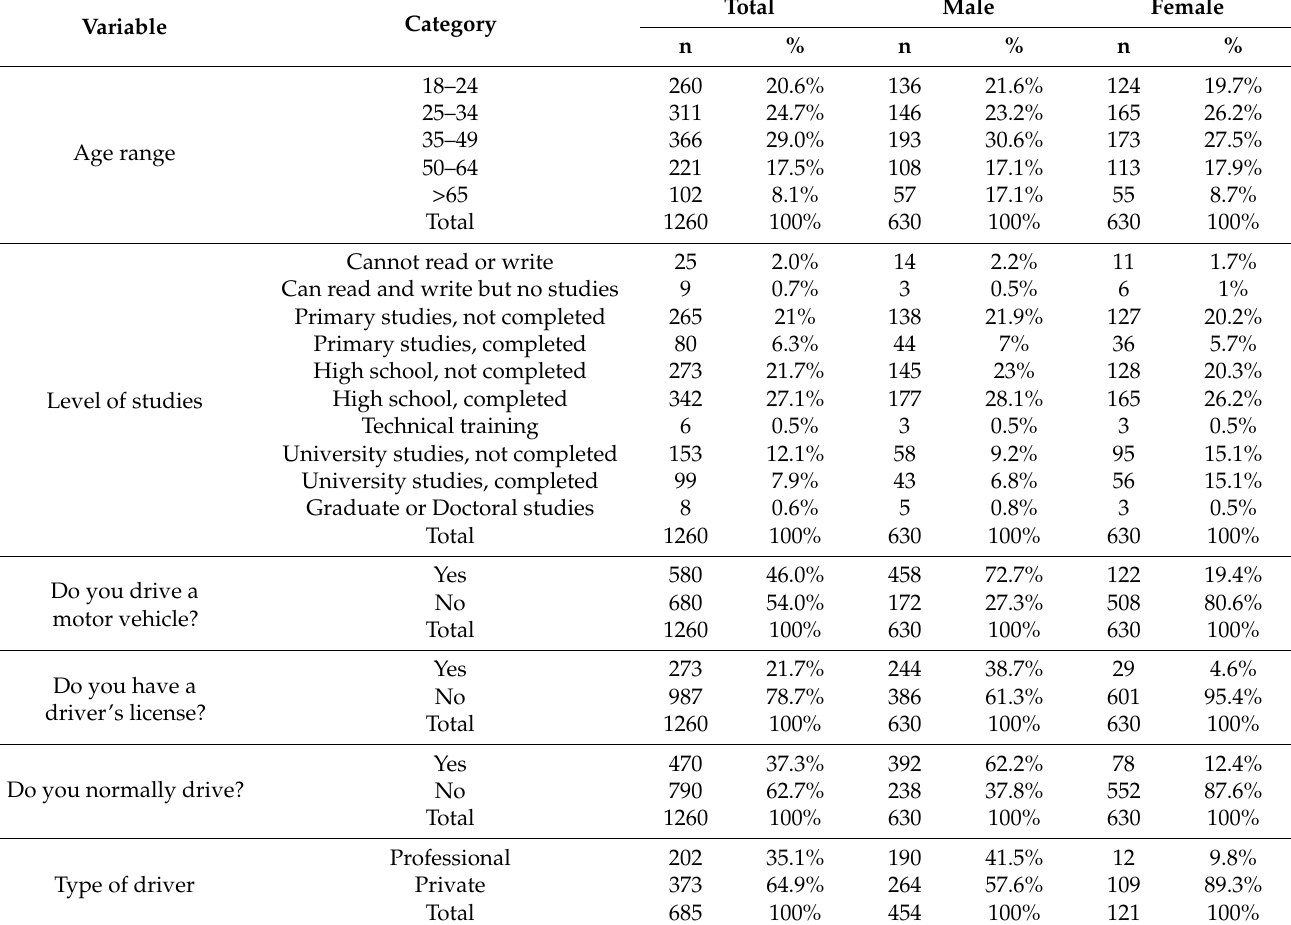
Table 1. Sociodemographic data of the study